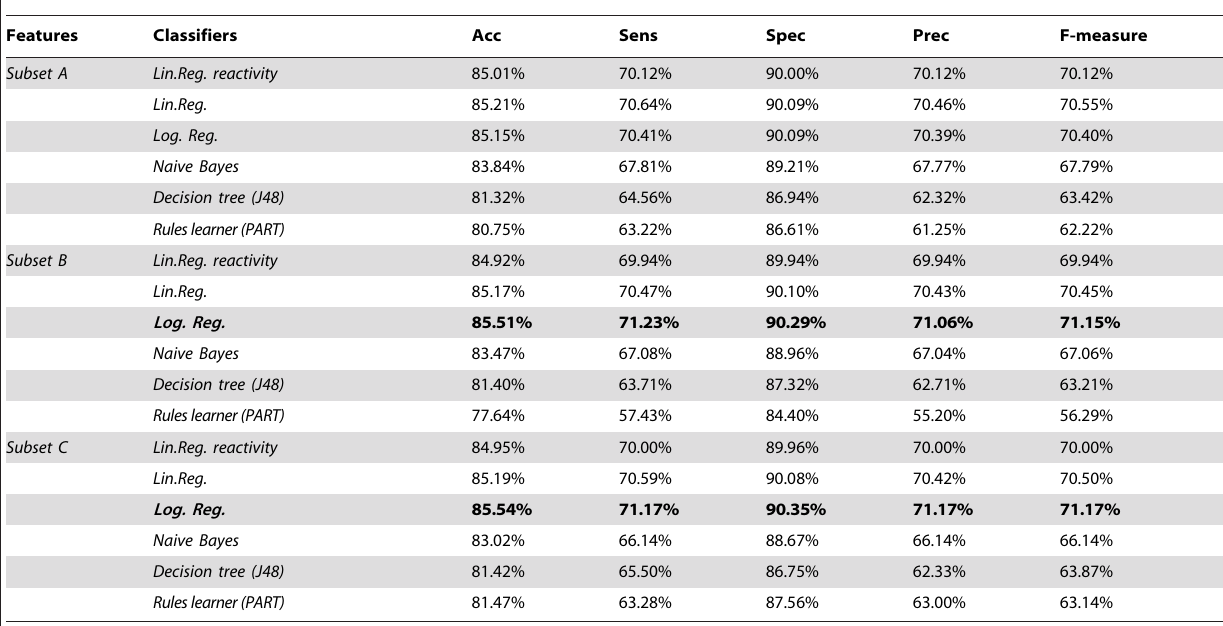
Table 3. Results of the classifiers evaluated by leave-one-out